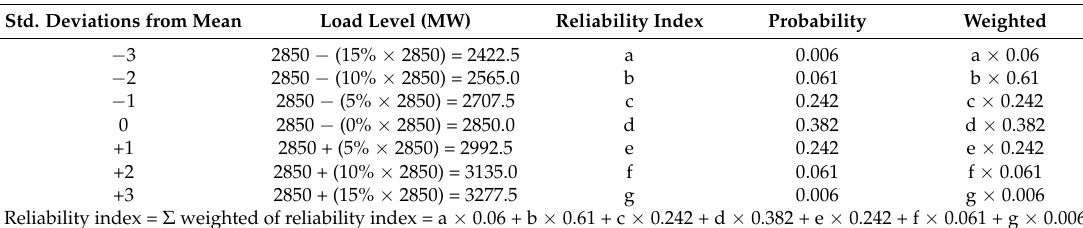
Table 2. Reliability indices incorporating